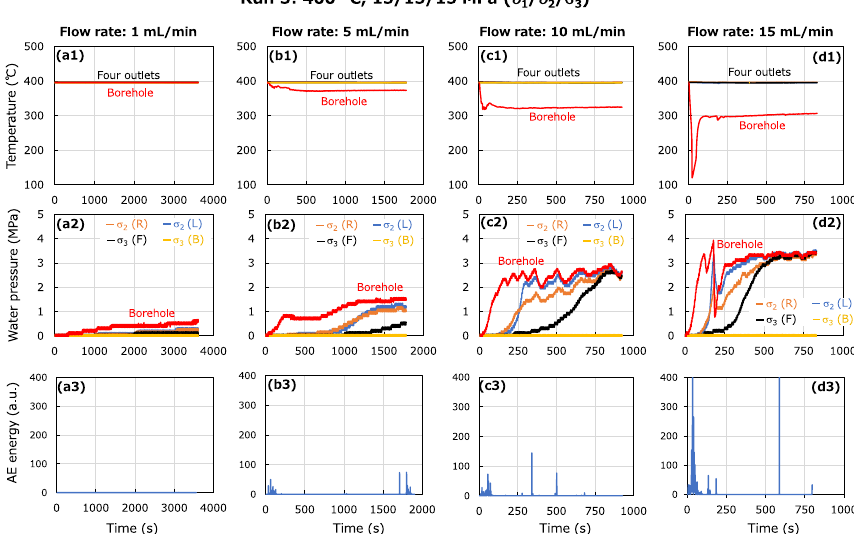
Fig. 8 Temporal changes in temperatures and water pressures for the borehole and four outlet faces, and